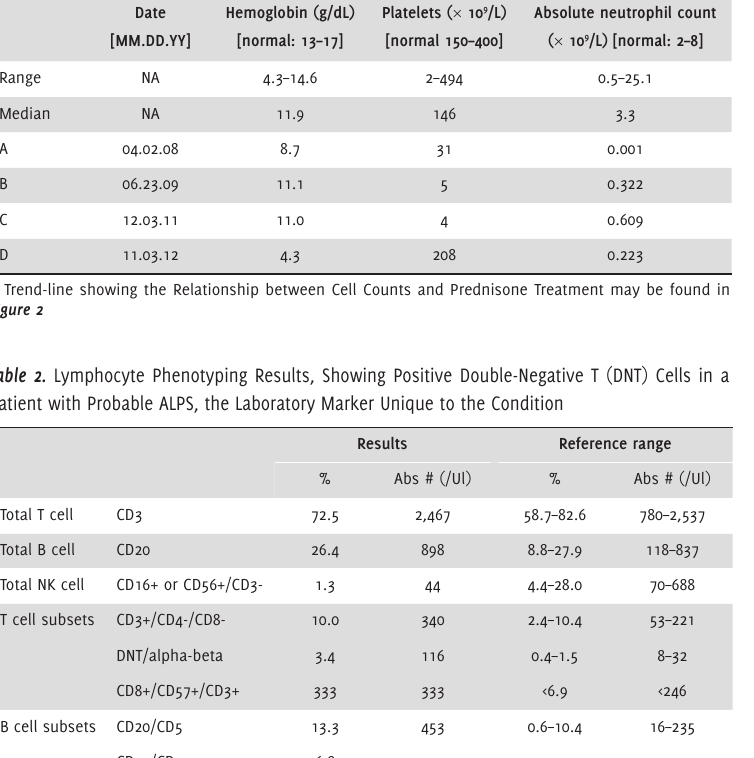
Table 1. Median, Range and Select Severe Values for Hemoglobin, Platelets and Absolute Neutro- phils (ANC) in a Patient with Probable ALPS